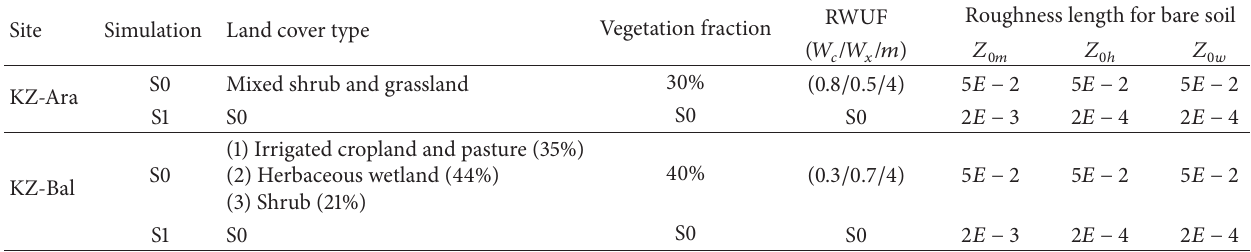
Table 2: The parameterizations of the reference model (S0) and the model with refined roughness length (S1) in CLM at KZ-Ara site and KZ-Bal site. RWUF is an optimal root water uptake function for dryland ecosystem (Jing et al. 2014 [21]), and 𝑊 𝑐 , 𝑊 𝑥 , and 𝑚 are empirical constants in RWUF.